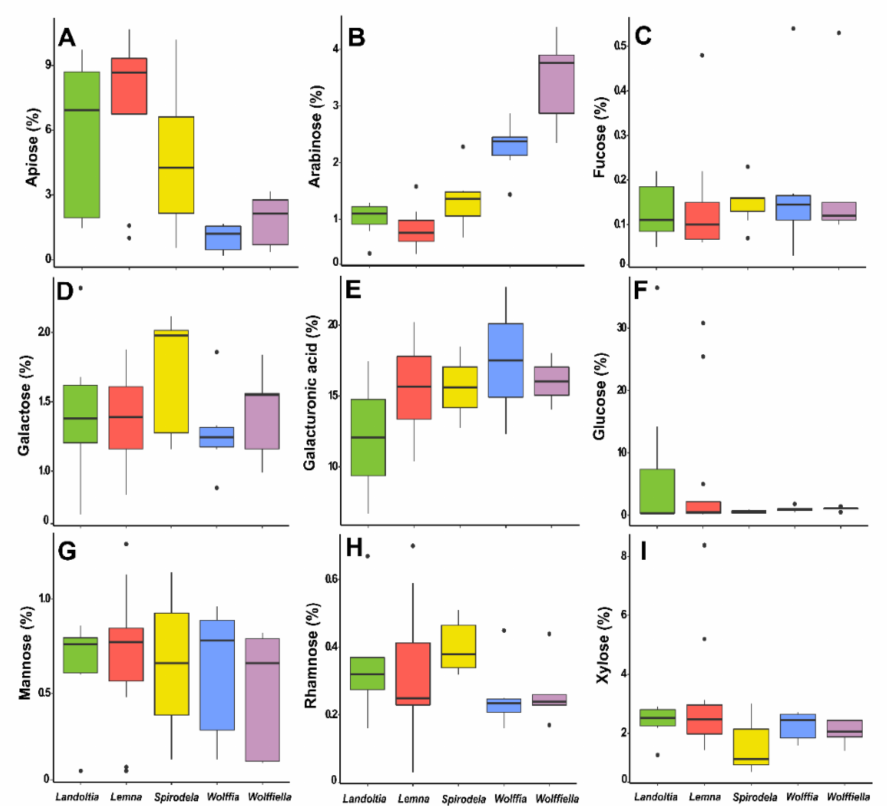
Figure 6. Monosaccharides from the cell wall of duckweeds. Data showed the intact cell wall (alcohol- insoluble residue—AIR). ( A ) Apiose (% biomass). ( B ) Arabinose (% biomass). ( C ) Fucose (% biomass). ( D ) Galactose (% biomass). ( E ) Galacturonic acid (% biomass). ( F ) Glucose (% biomass). ( G ) Mannose (% biomass). ( H ) Rhamnose (% biomass). ( I ) Xylose (%